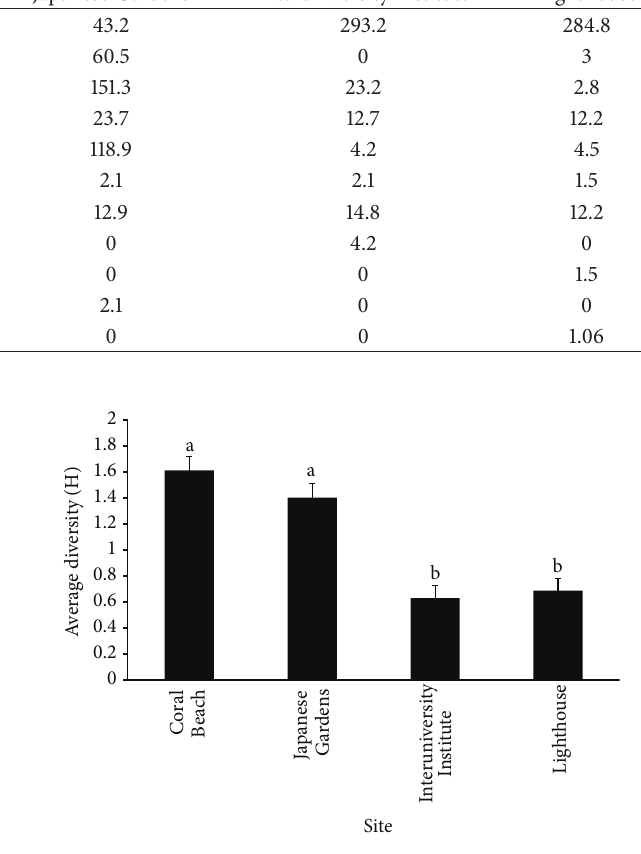
Figure 2: Diversity (Shannon-Weaver H ( ± S.E.)) of the holothuroid community in the 4 sites sampled. Different letters denote a significant difference between sites ( 𝑃 < 0.05 , ANOVA followed by post hoc Student’s 𝑡